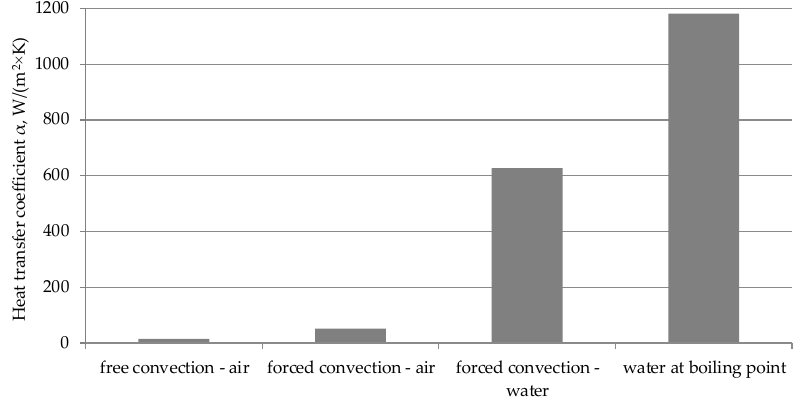
Figure 1. Example values of α for air (for free and forced convection) and for water (for forced convection and laminar flow and for